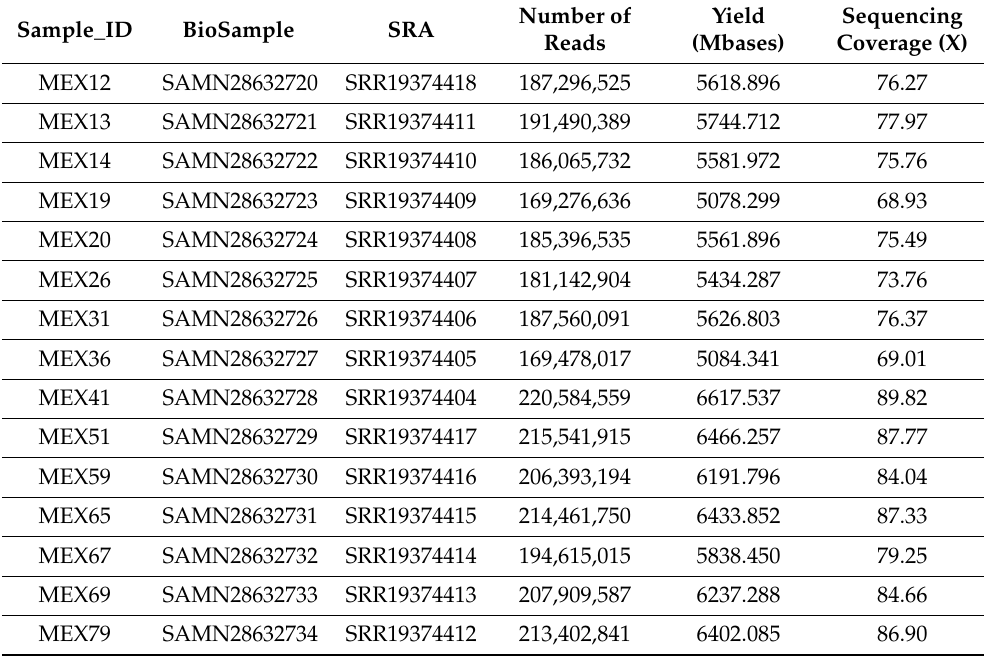
Table 1. Attributes and identifiers of generated genomic data used in this study. Raw genome coverage was calculated based on the 1-C reference genome size (736,752,966 bp) from the BioProject